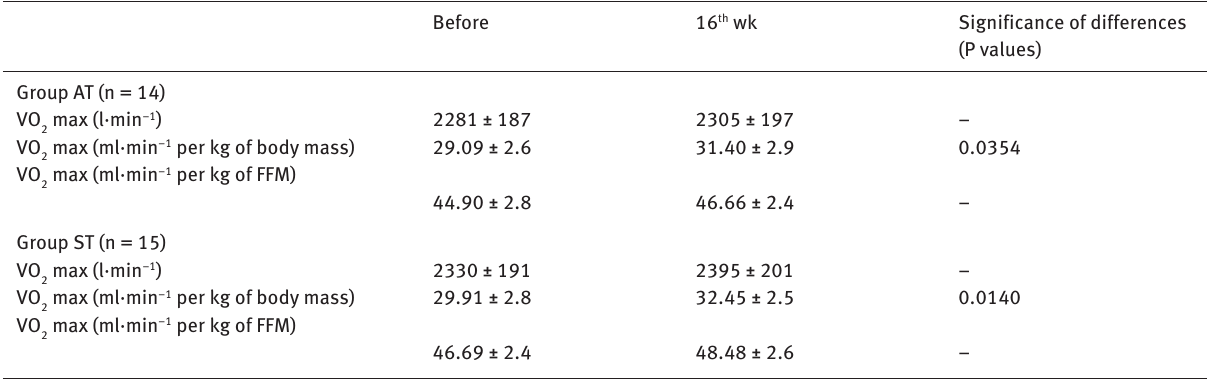
Table 5: Maximal oxygen uptake changes related to 16 wks of aerobic (AT group) and strength (ST group) training of overweight females (mean ± SD). Before